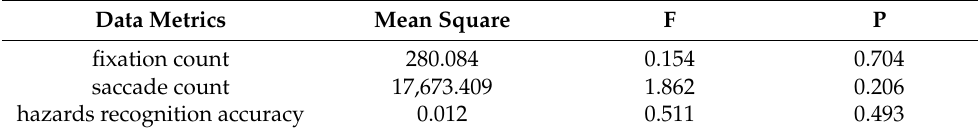
Table 3. Analysis of experimental data difference between two hazard perception test methods.